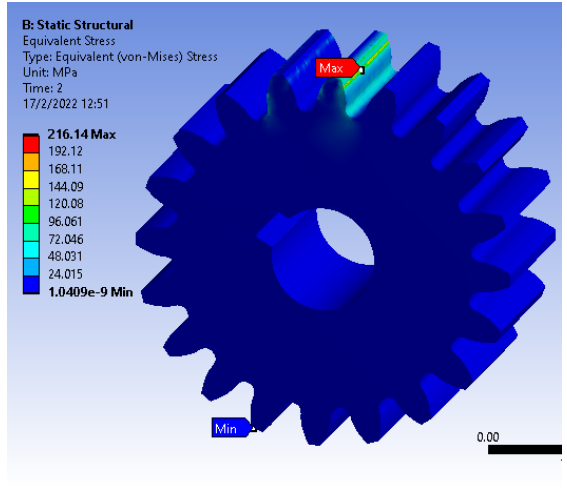
Figure 4. Pinion stress. Figure 4. Pinion